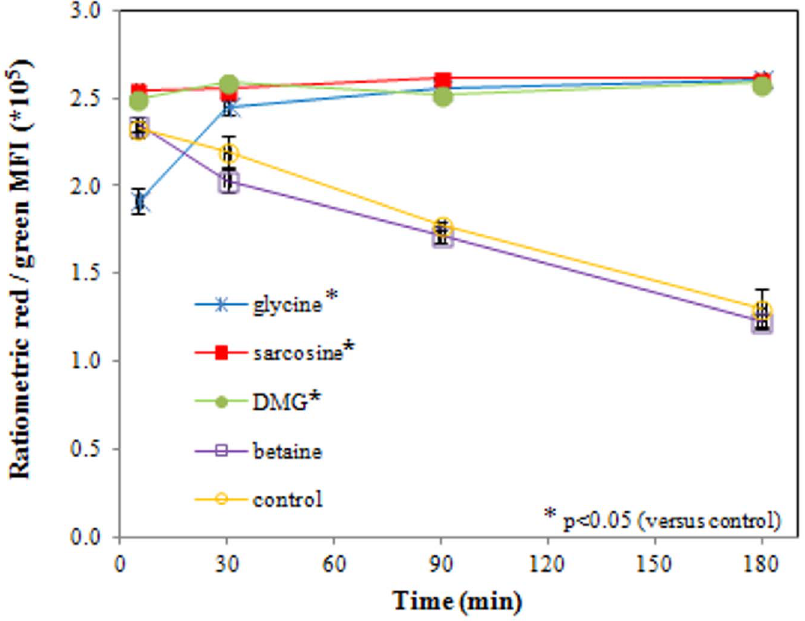
Figure 6. Ratiometric red/green fluorescence presenting E.coli membrane potential. Ratiometric membrane potential measurements showed a significant hyperpolarization of the ETEC membrane following exposure to glycine, sarcosine and DMG (50 mM, pH 9.5) after 90 min of incubation, compared to the control (p , 0.0005, p=0.002 and p , 0.0005, respectively). In the betaine-exposed and control samples there is a time- dependent depolarization of ETEC. Data are expressed as means 6 SD of triplicate experiments.